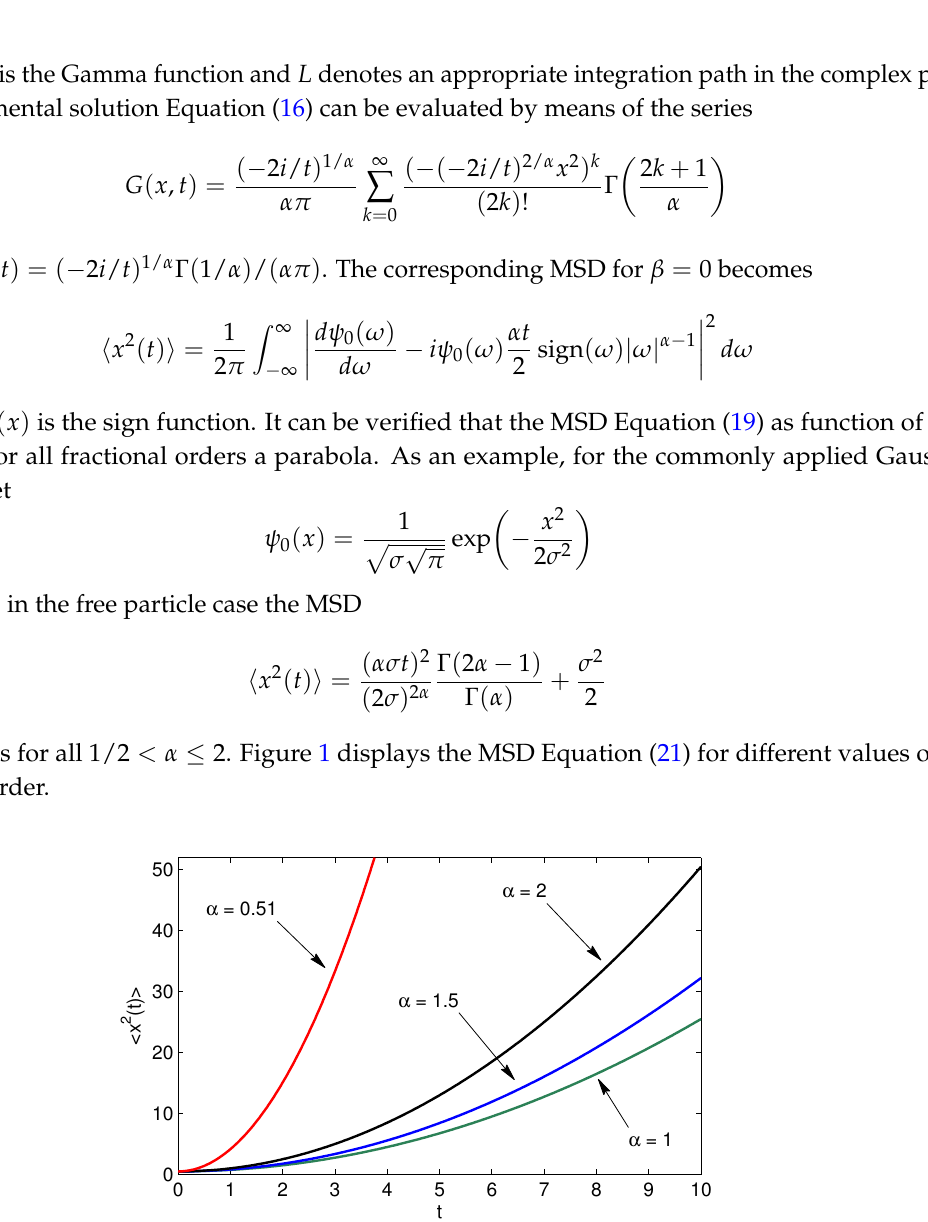
Figure 1. Illustration of the mean square displacement (MSD) Equation (21) for different values of the fractional order α under consideration of the Gaussian initial wave packet Equation (20) with σ =